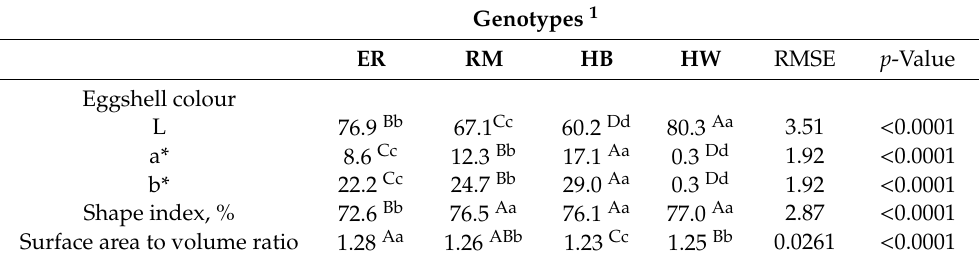
Di ff erent letters in a row indicate di ff erent values. a, b, c, d: p < 0.05; A, B, C, D: p < 0.01. RMSE = Root Mean Squared Error. 1 Genotypes: ER—Ermellinata di Rovigo; RM—Robusta maculata; HB—Hy Line Brown; HW—Hy Line White 36. Observations ( n ): ER (31); RM (31); HB (30); HW